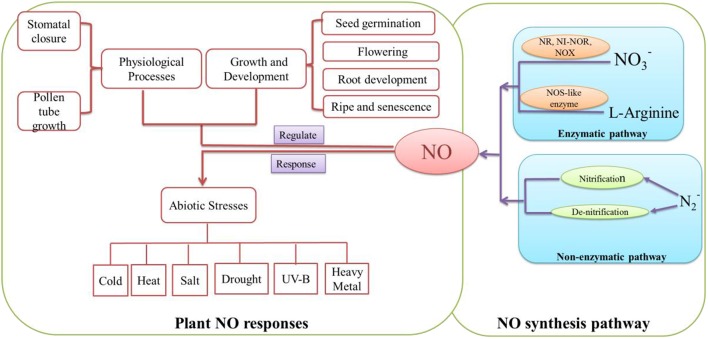
Summary of the main NO systhetic pathways and NO functions in plant growth, development and defense processes. NO may be synthesized by enzymatically and non-enzymatically pathways. In enzymatic pathway, nitrate reductase (NR; Rockel et al., 2002), Nitrite-NO reductase (Ni-NOR; Stöhr et al., 2001) and xanthine oxidase (XOR; Corpas et al., 2004) could convert NO3- and NO2- to NO. Meanwhile, because of NOS-like enzyme (Guo et al., 2003), L-Arginine may be catalyzed to NO. In non-enzymatic pathway, N2- could be transformed to NO through nitrification and denitrification (Skiba et al., 1993). NO plays an important signaling molecule in plant. It could regulate developmental and physiological processes such as seed germination (Wang et al., 2015), root development (Liao et al., 2011) and stomatal closure (Shi C. et al., 2015). Also, it may be involved in response to abiotic stresses such as cold (Fan et al., 2015), salt (Liu W. et al., 2015) and drought (Shan et al., 2015).